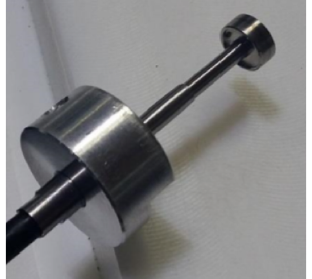
Figure 4: Miniaturized fission chamber